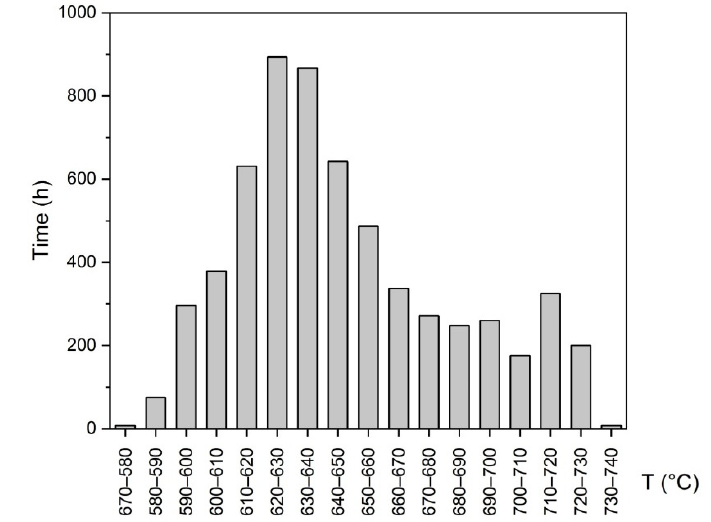
Figure 1. Power plant boiler operation temperature histogram.